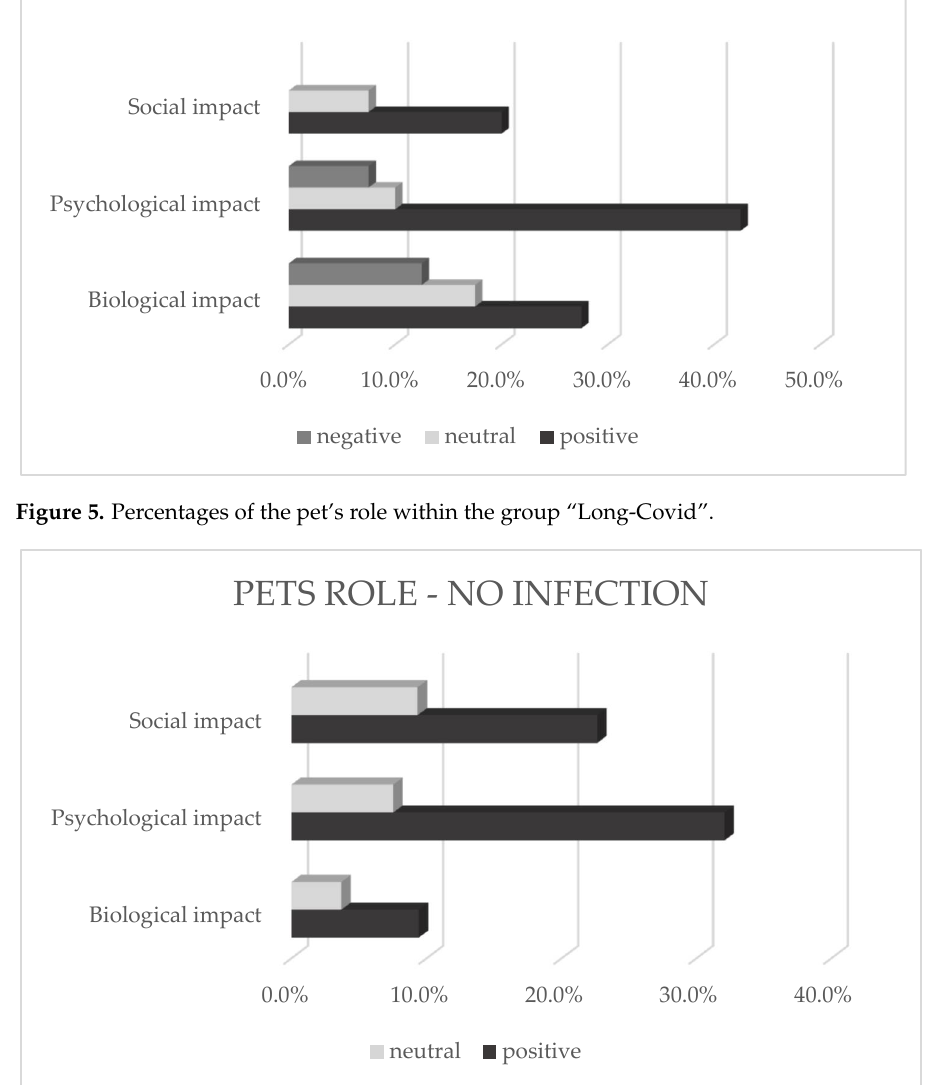
Figure 6. Percentages of the pet’s role within the group “No infection”.